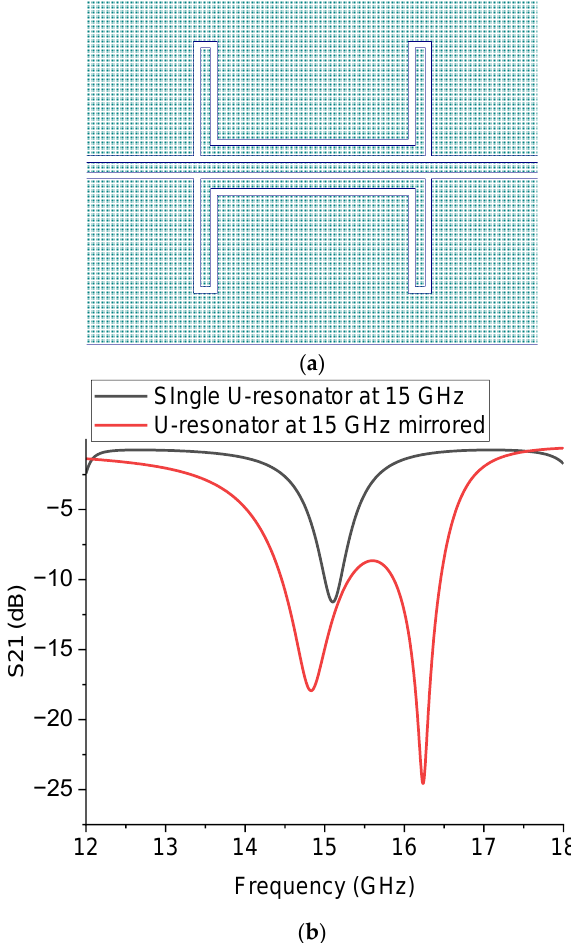
Figure 15. U-shaped resonator ( a ) and its predicted response comparing the single structure and the mirrored one ( b ). mirrored one ( b